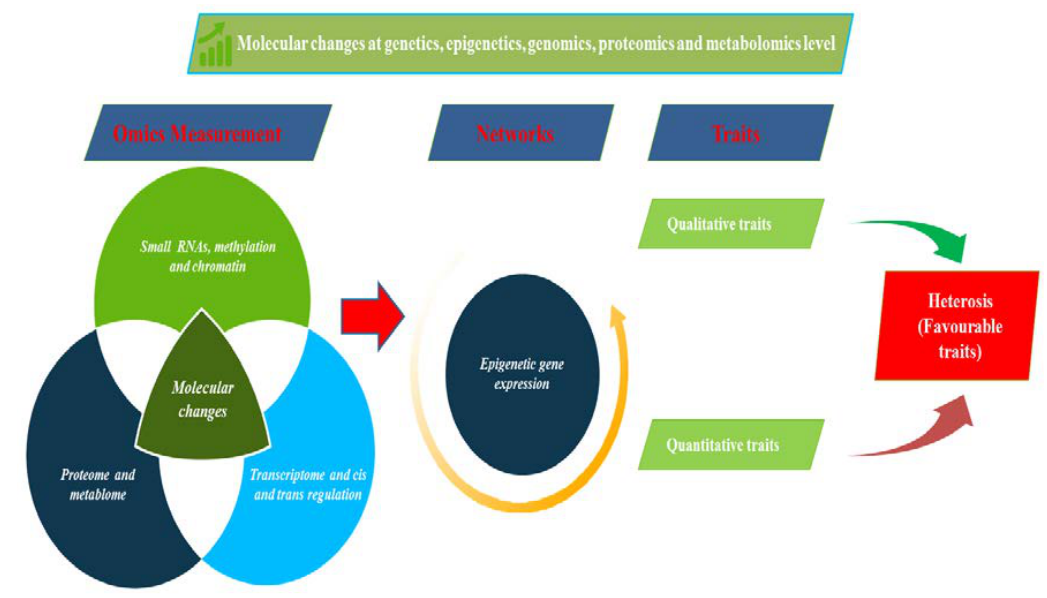
Figure 2. Molecular changes at genetics, epigenetic, genomic, proteomic, and metabolic levels leading to favorable heterosis traits.